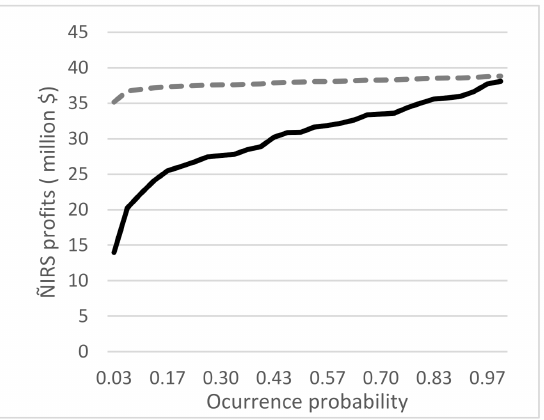
Figure 4. Economic profits of the ÑRIS. Hydrologic occurrence probability for market profits under current (solid line) and perfect (dotted line) market conditions.